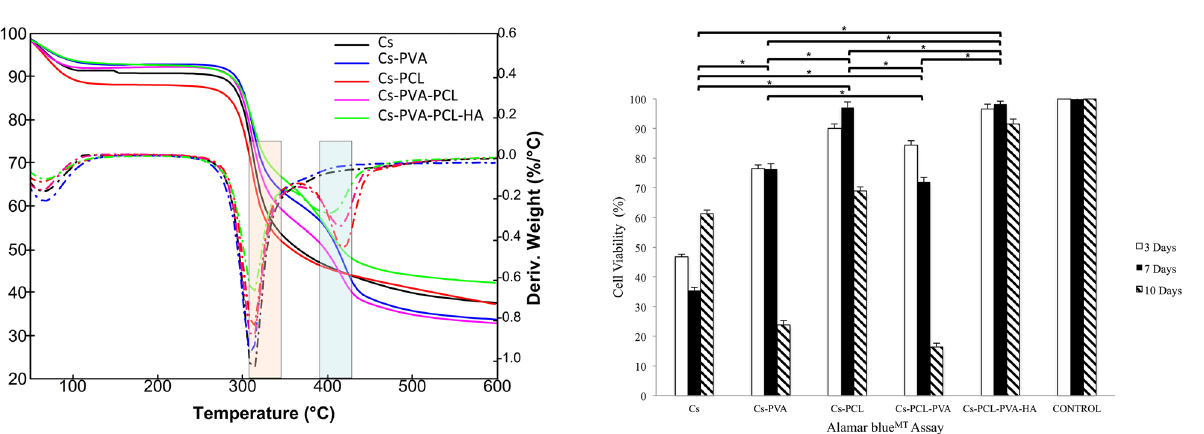
Fig. 5 Cell viability (Alamar blue TM cell metabolic assay) in control and in 3D scaffolds groups. ANOVA one way, P < 0.05, Tukey ’ s test. * Indicates statistically signi fi cant difference between